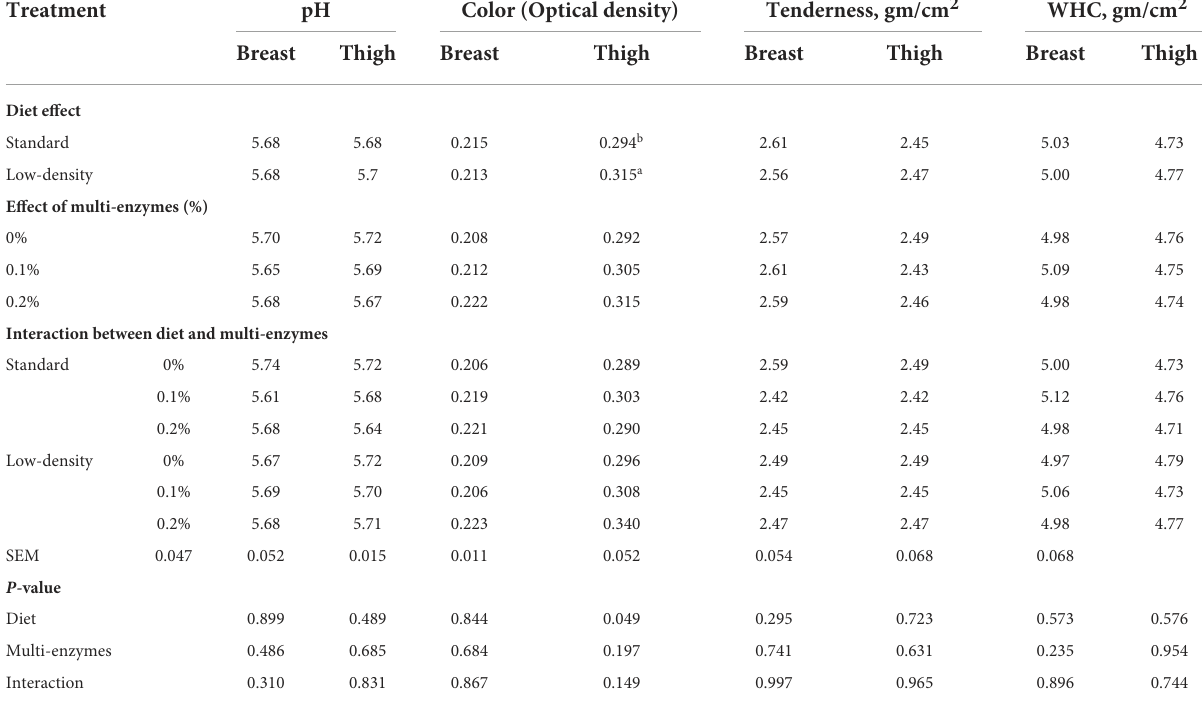
TABLE 6 Physical traits of broiler meat 1 fed standard and low-density diets supplemented with different concentrations of multi-enzymes from 1 to 38 days of age. Treatment pH Color (Optical density) Tenderness, gm/cm 2 WHC, gm/cm 2 Breast Thigh Breast Thigh Breast Thigh Breast Thigh